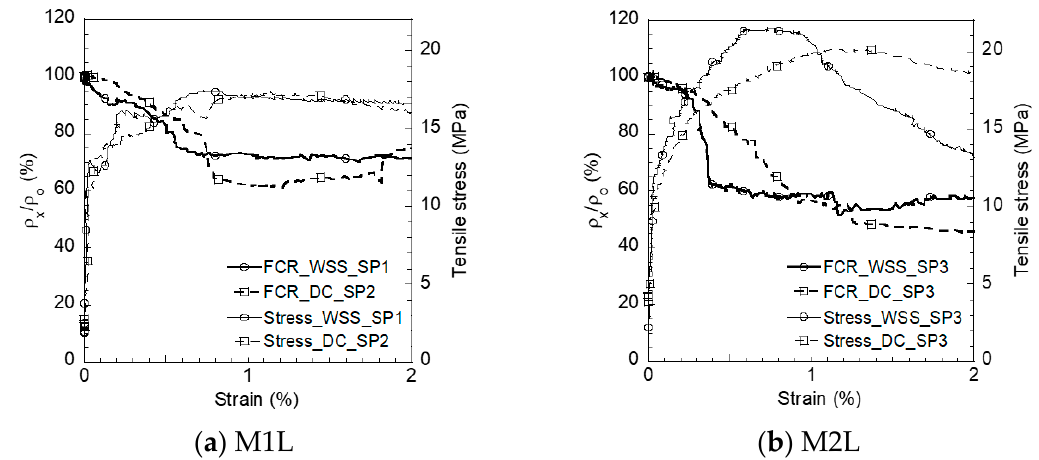
Figure 16. Electrical resistivity response of S-UHPCs under tension.